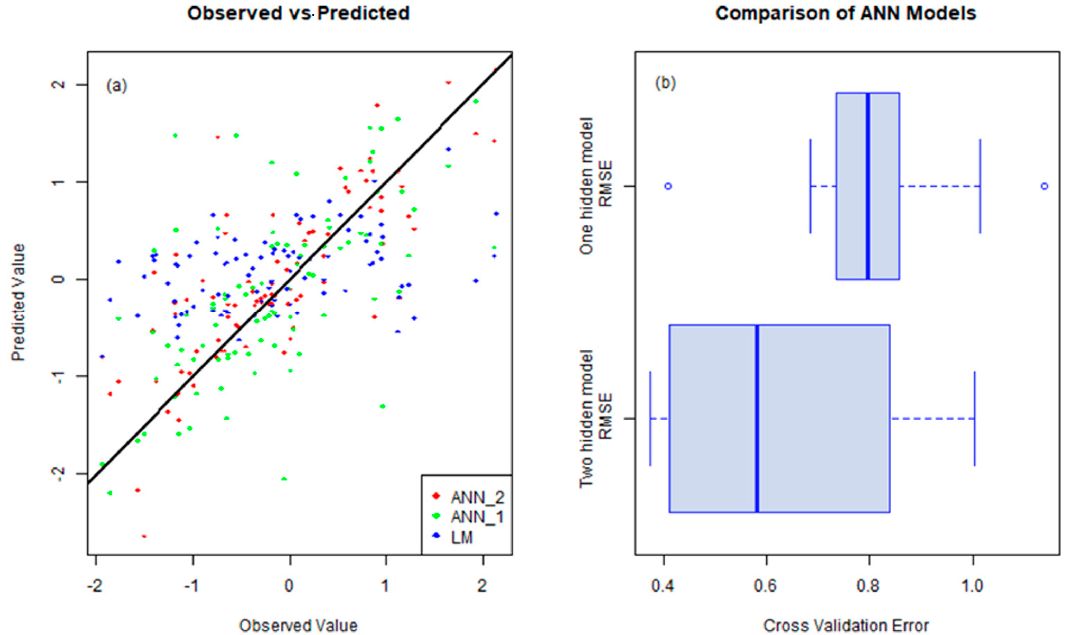
Figure 11. ( a ) A scatterplot of the observed versus predicted plots for the two-layer ANN (ANN_2), one-layer ANN (ANN_1), and linear models (LM) with a 1:1 reference line plot. ( b ) The 10-fold cross-validation root-mean-square errors for the two-layer ANN and one-layer ANN models.